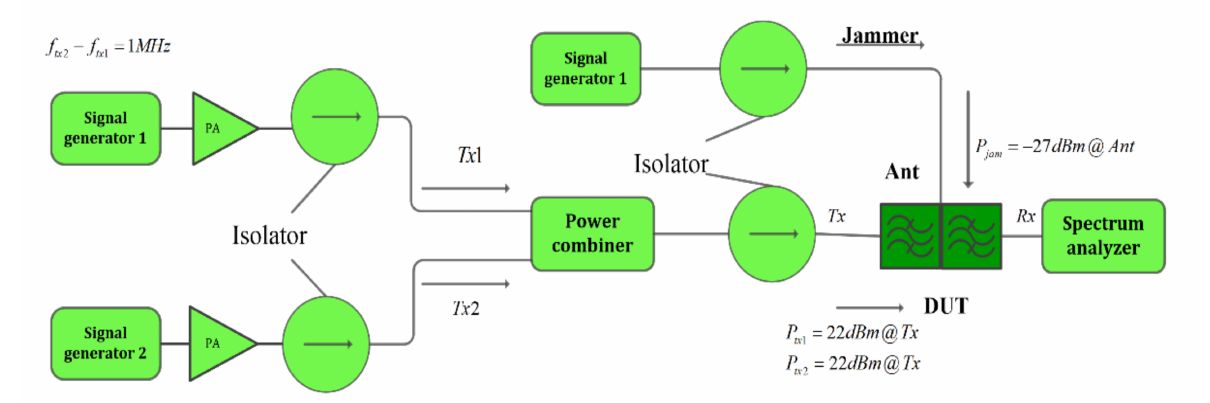
Figure 10. Setup for triple beat